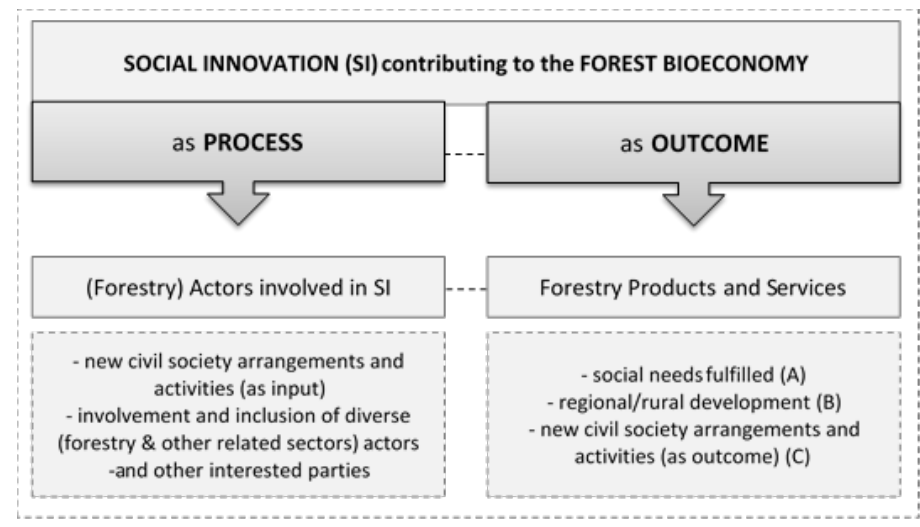
Figure 1. Role of social innovation as process and outcome in the forest bioeconomy.